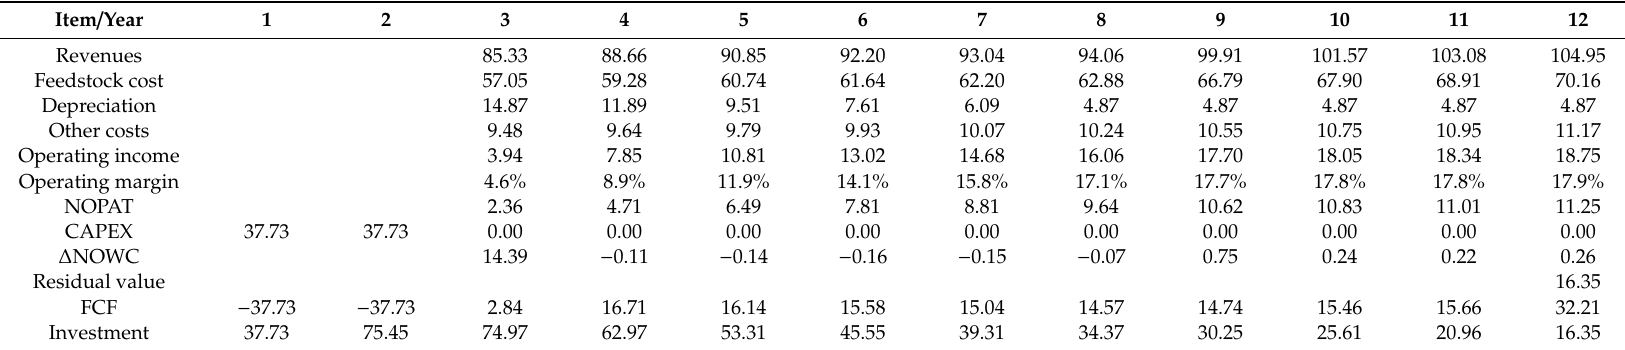
Table 6. Forecast free cash flows and selected financial metrics yielding NPV = 0 and modified internal rate of return (MIRR) = 12.5% with feedstock buying price = 23.8 ¢ kg − 1